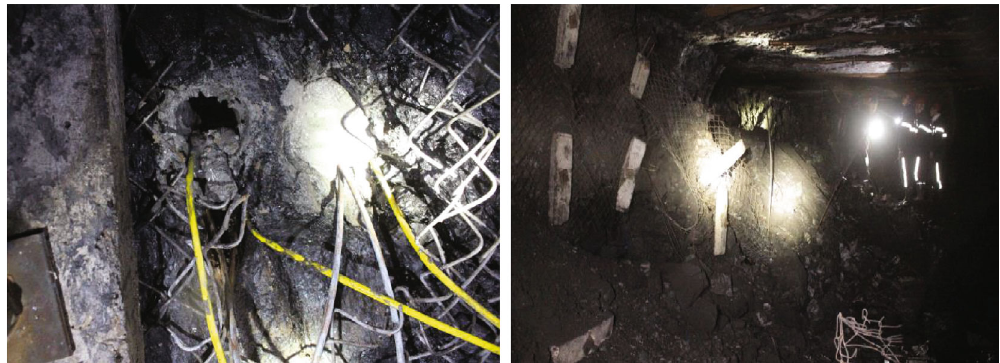
Figure 11: Water injection in the blasting hole.